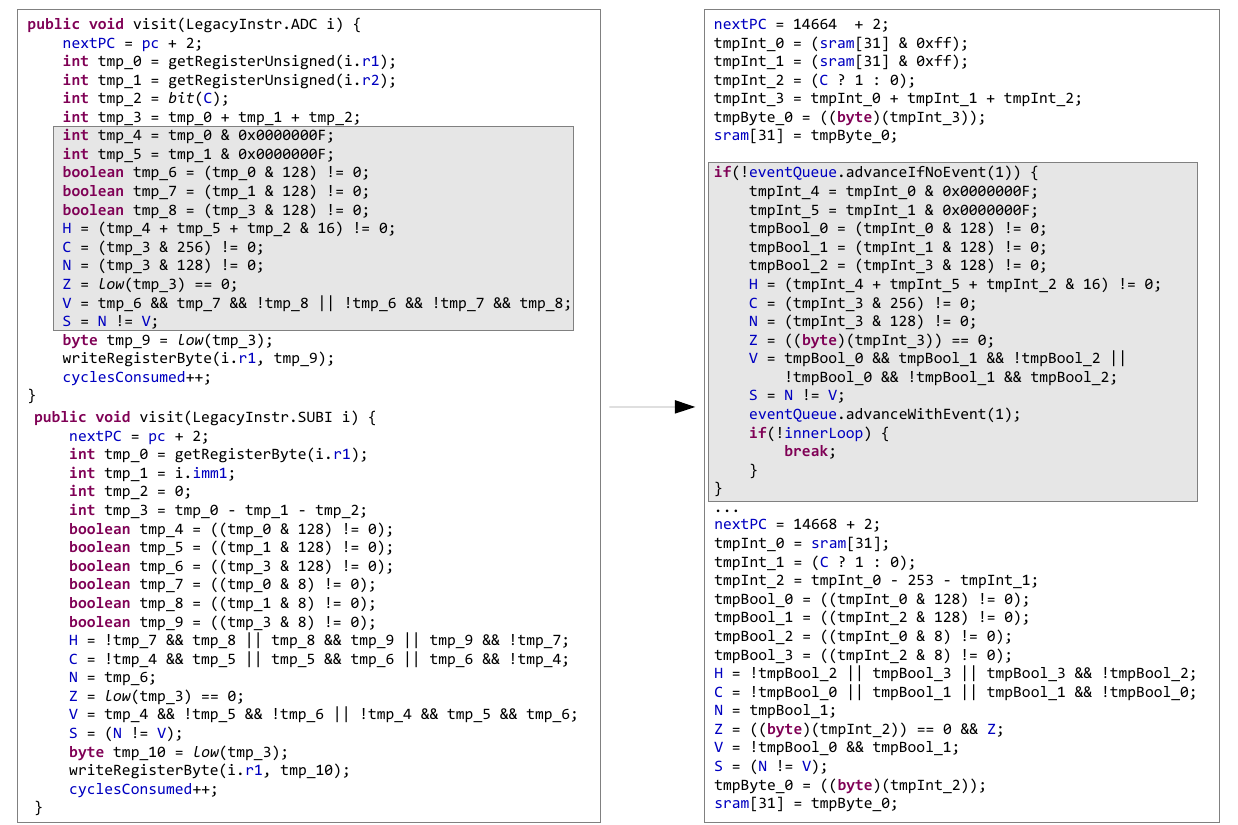
Figure 2: Example for conditional execution of potentially unnecessary